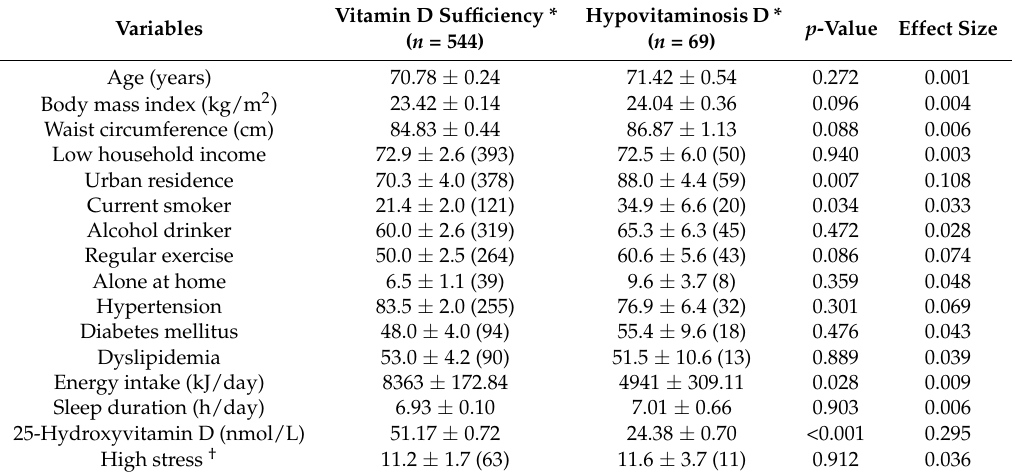
Table 2. General characteristics of men according to vitamin D levels.